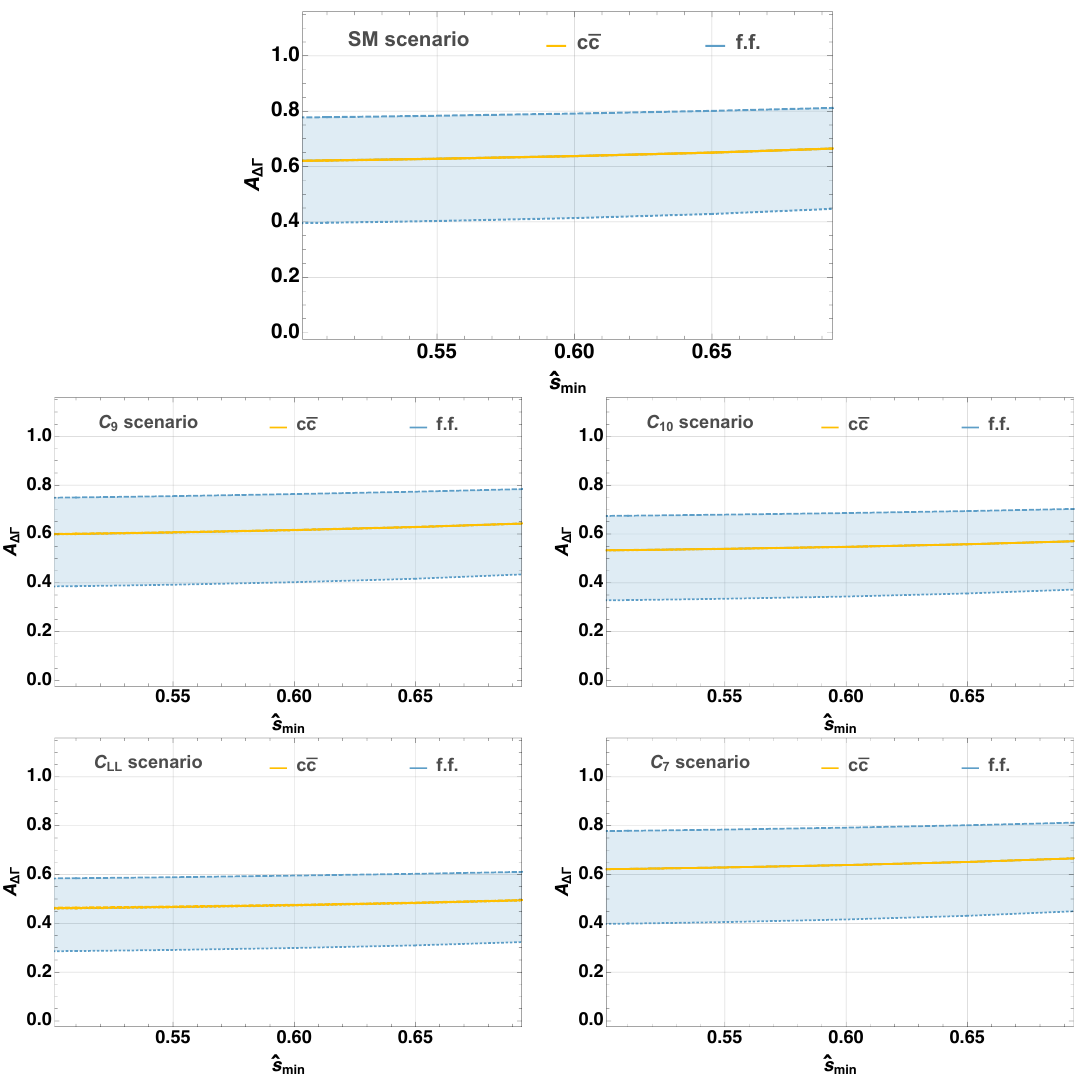
prediction in the kinematic interval [ˆ s Figure 5 . A µµγ ∆Γ s the f.f. error, and respectively on the uncertainty associated to the modelling of broad-charmonium resonances. See text for